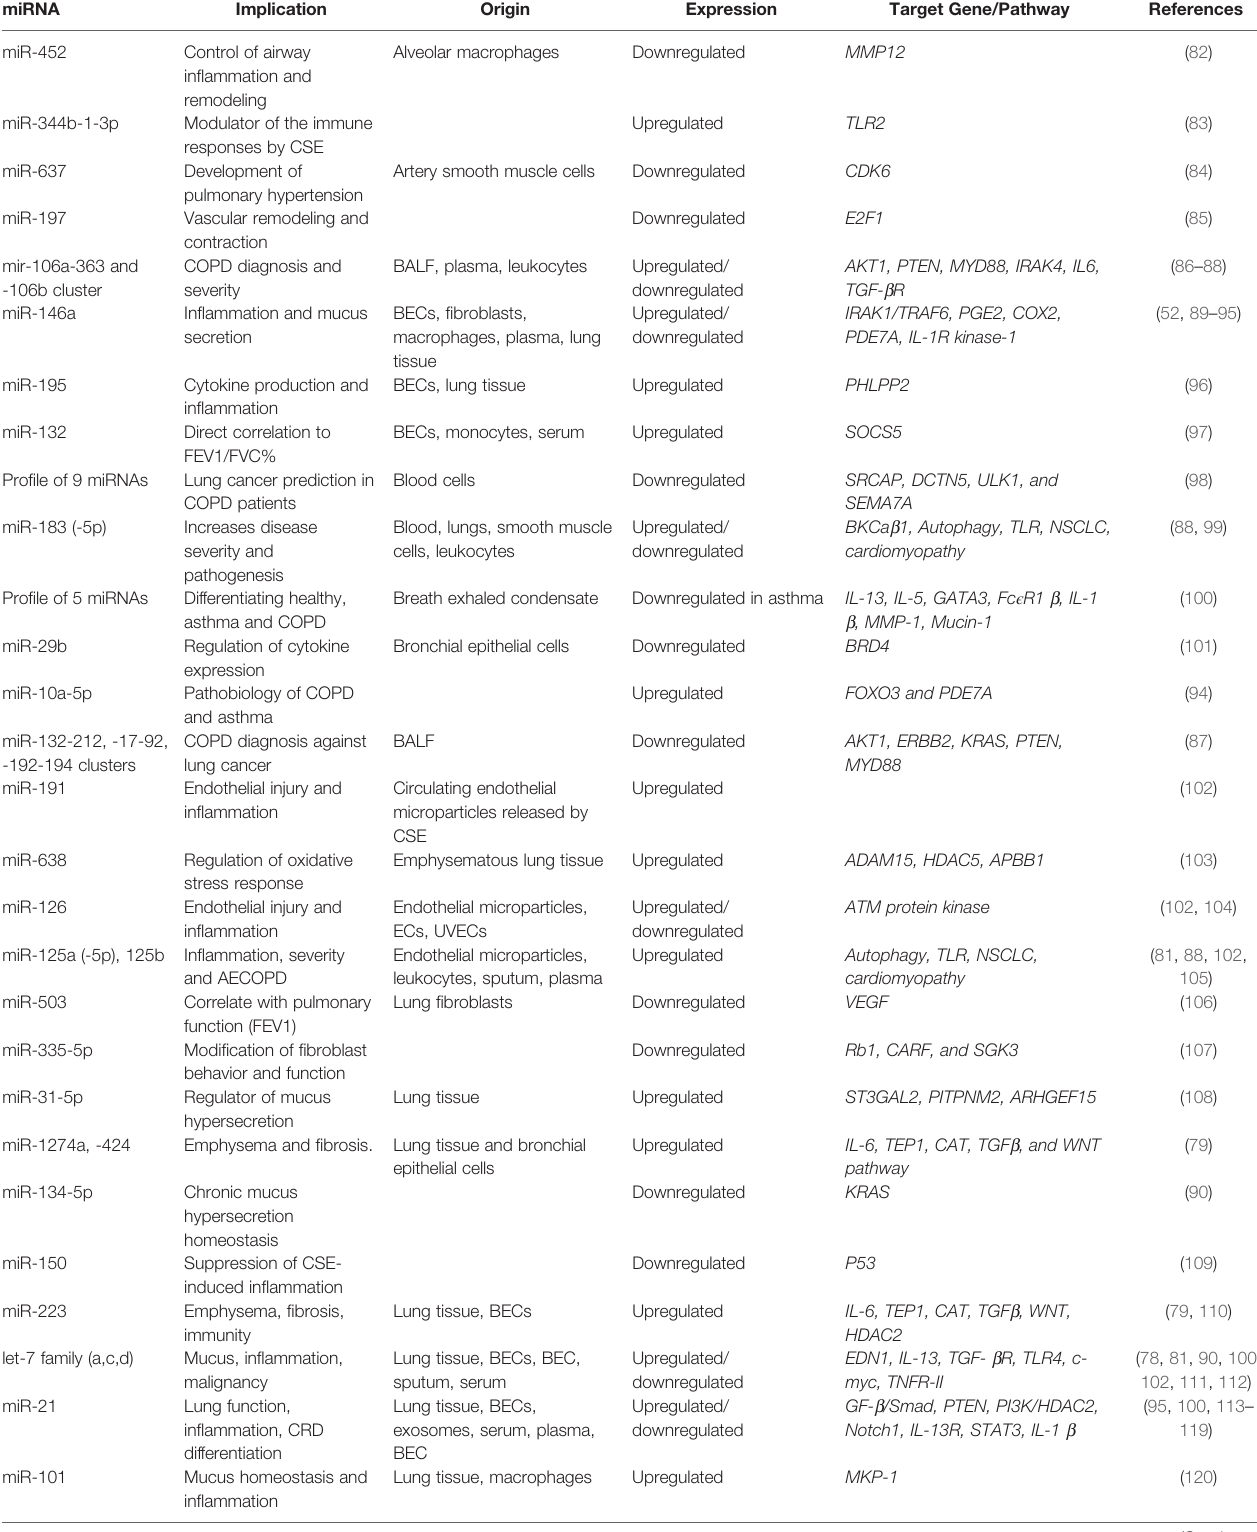
TABLE 2 | List of miRNAs involved in COPD pathogenesis and diagnosis.